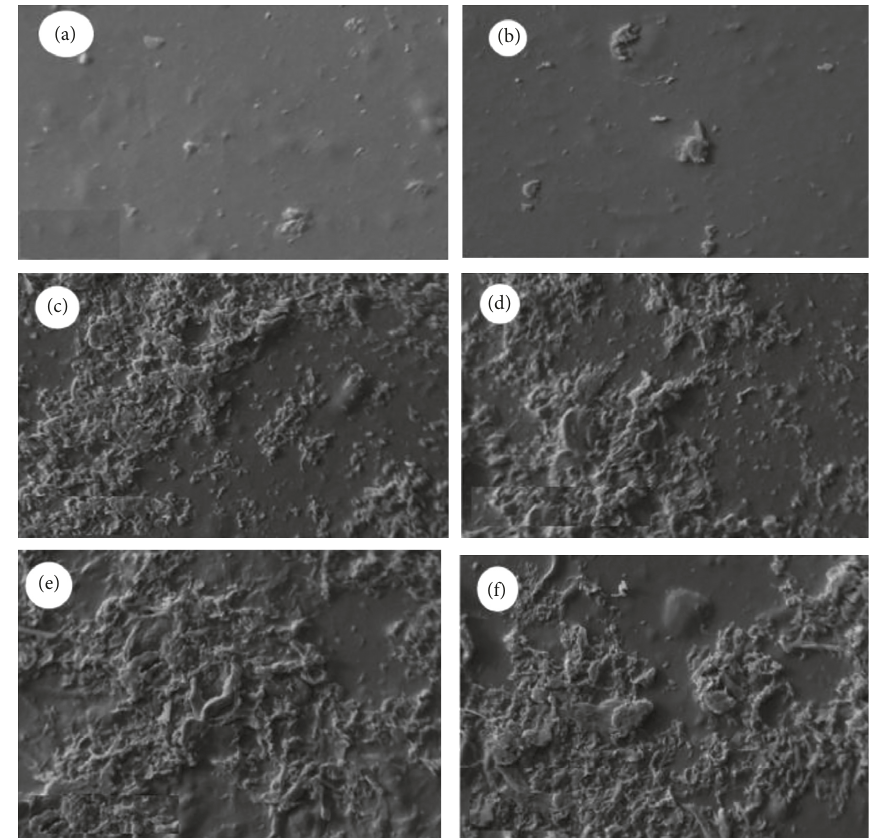
Figure 1: Scanning electron microscope (SEM) micrographs of chitosan films (1% and 2%) with cellulose nanofibers (0%, 3%, and 5%): (a) film with 1% chitosan; (b) film with 2% chitosan; (c) film with 1% chitosan+3% CNF; (d) film with 2% chitosan+3% CNF; (e) film with 1% chitosan+5% CNF; and (f) film with 2% chitosan+5%